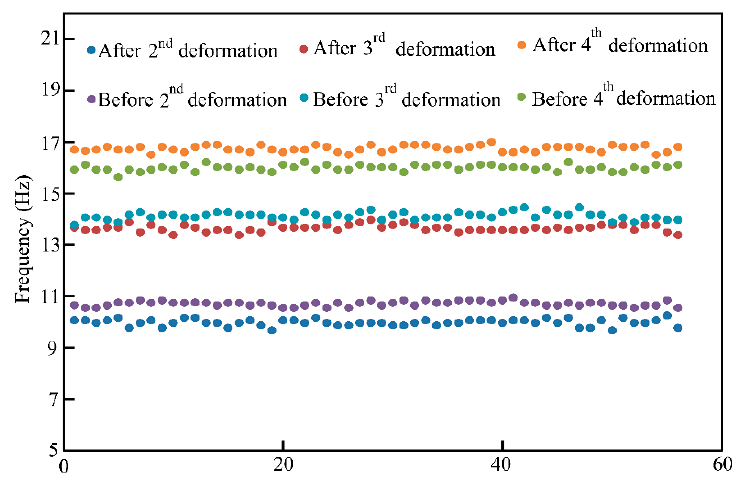
Figure 10. Changes in the natural frequencies of each order.